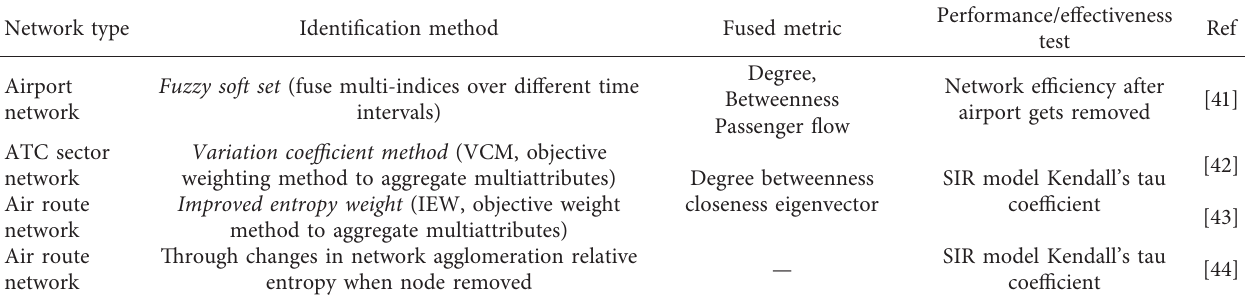
Table 4: Comparison of multimetric-based